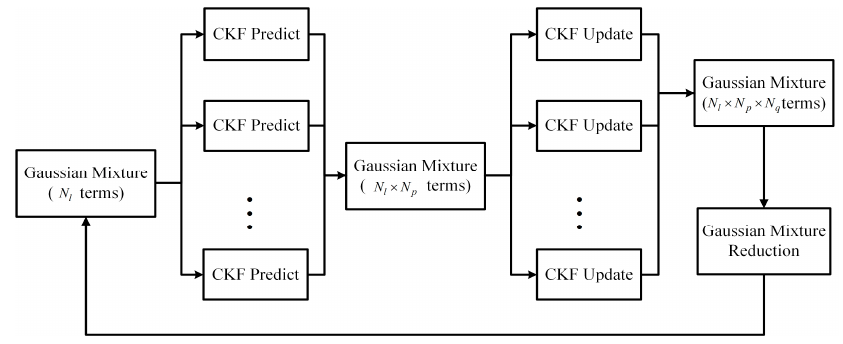
Figure 1. One filtering cycle of the cubature Gaussian mixture filter (CGMF).